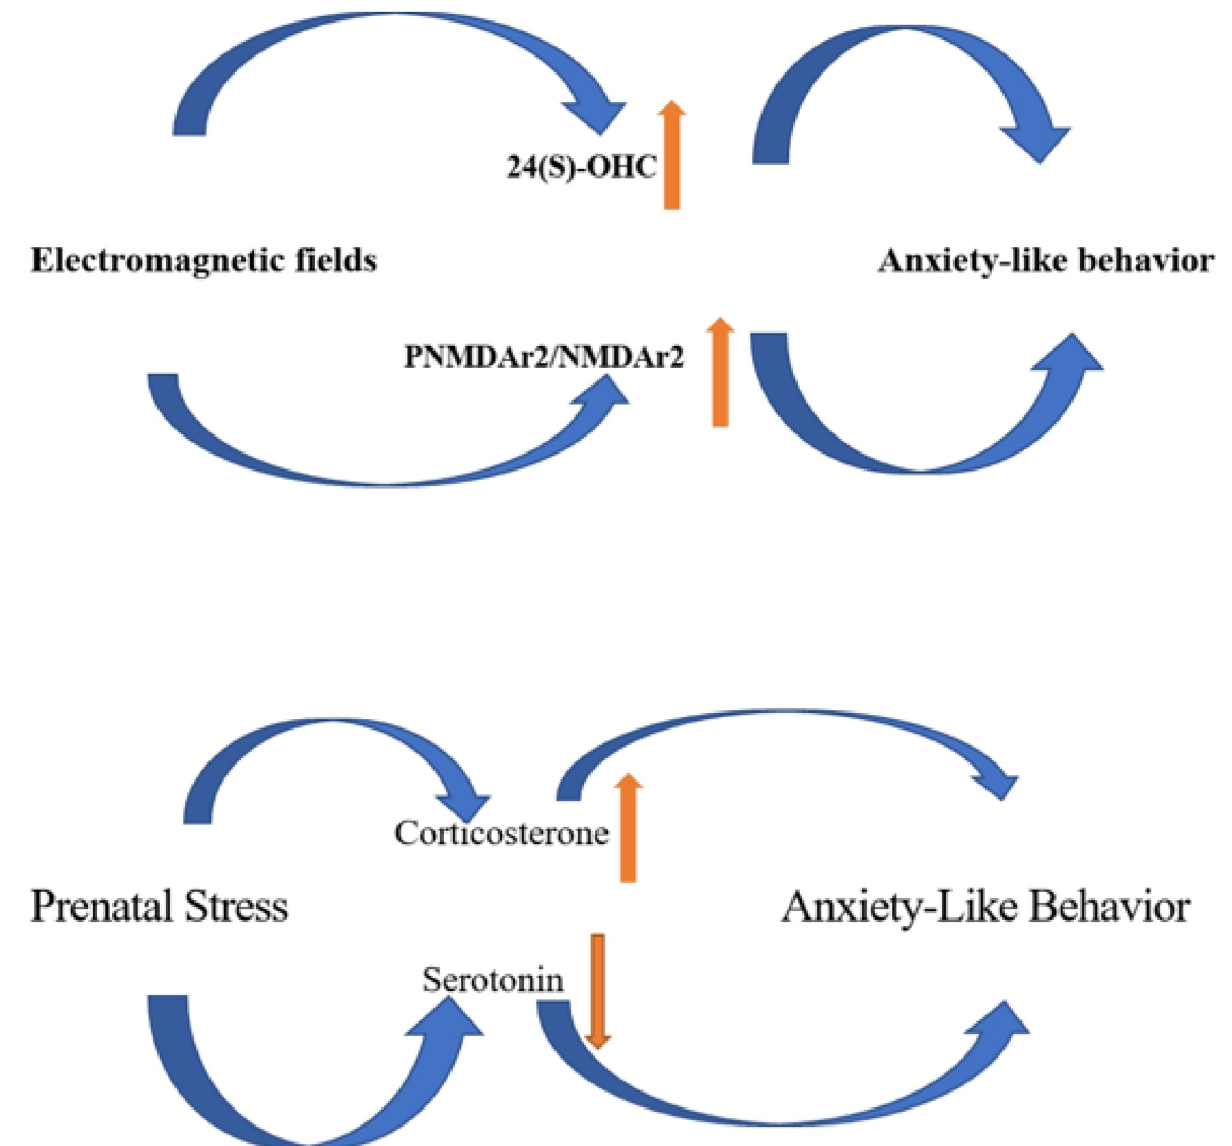
Fig 7. Summary of how ELF-EMF and prenatal stress could be able to induce anxiety-like behavior in offspring by modification of neurostroids metabolism, serotonin and N-Methyl-D-Aspartate receptor 2(NMDAr2) in hippocampus. " indicating increasing effect, # indication decreasing